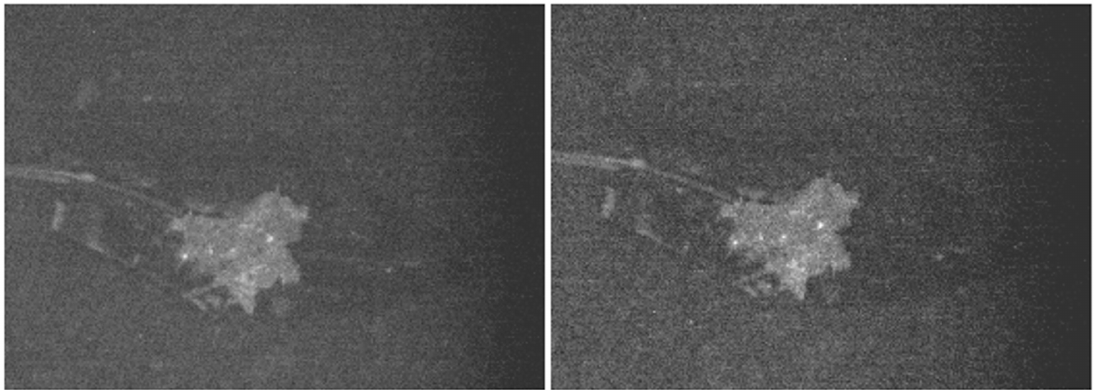
Figure 3. Gain 20 ( left ) and gain 32 ( right ) images at 525 nm of manure on a spinach leaf. Images were acquired at night with the drape raised 250 cm.